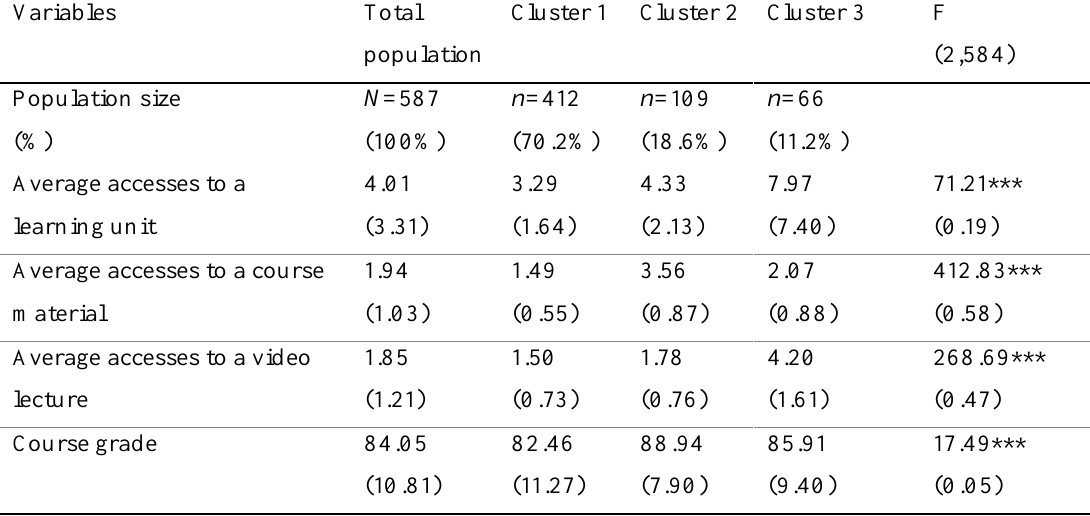
Clusters by Number of Re-Accesses to the Learning Resources